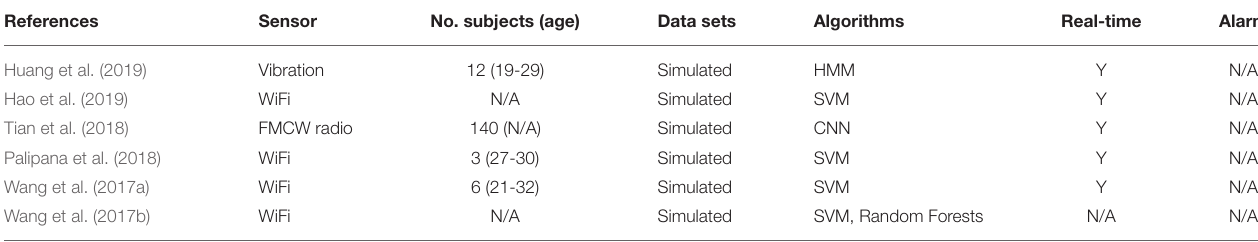
TABLE 5 | Fall detection using individual ambient devices from 2014 to